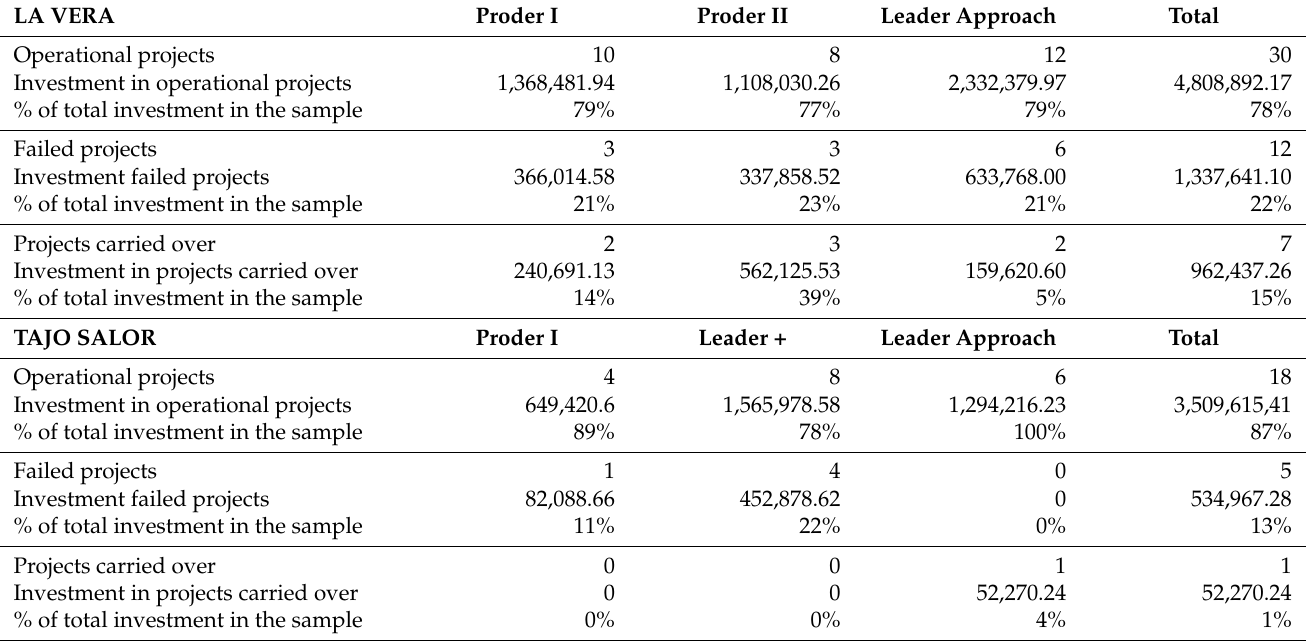
Table 7. Operational, failed and transferred projects in the regions of La Vera and